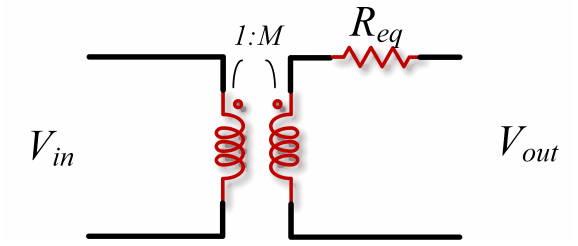
Figure 1. Equivalent model of